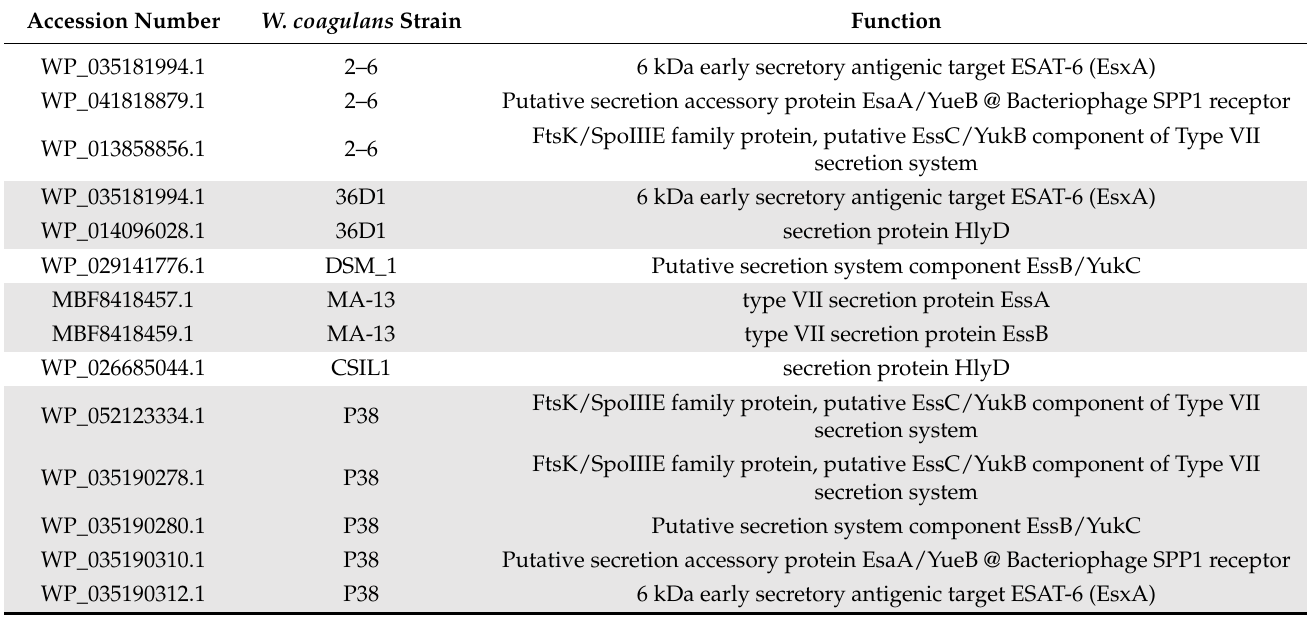
Table 3. Non-core genes of W.coagulans secretion